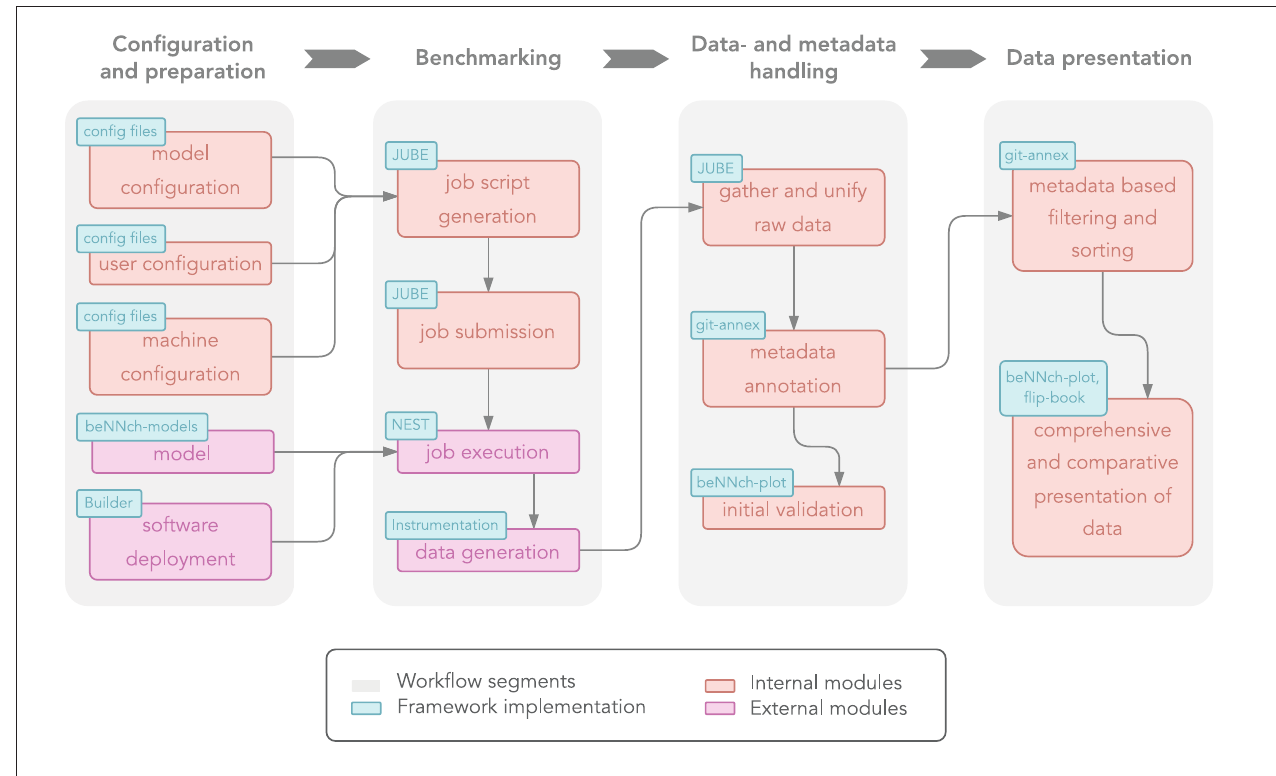
FIGURE 2 | Conceptual overview of the proposed benchmarking workflow. Light gray boxes divide the workflow into four distinct segments, each consisting of multiple modules. Internal modules are shown in orange and external ones in pink. Blue boxes indicate their respective realization in our reference